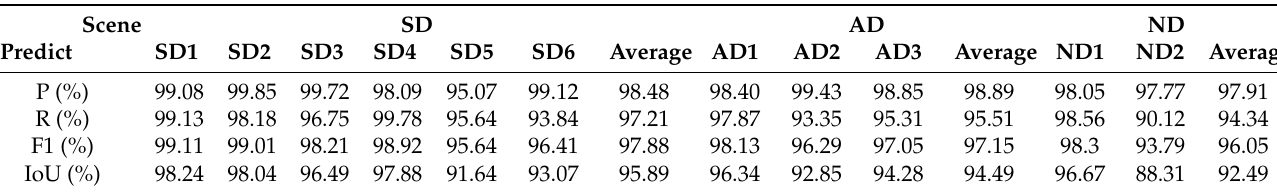
Table 3. Quantitative extraction results.